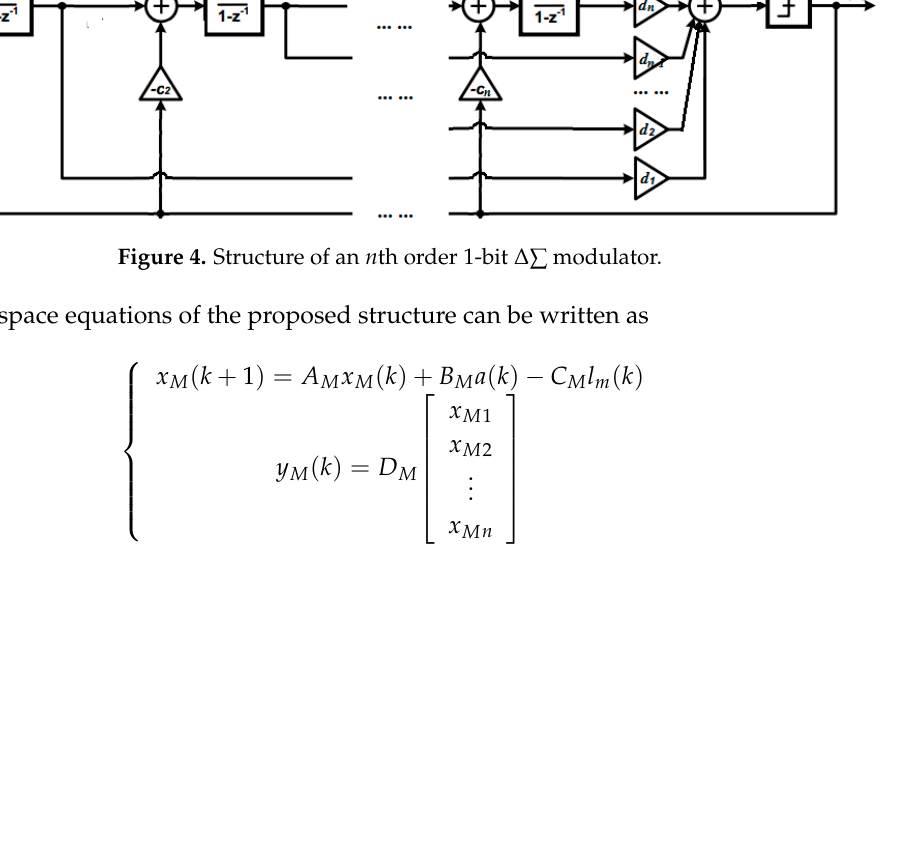
Figure 3. A third order 1-bit MEMS gyroscope with resonator.